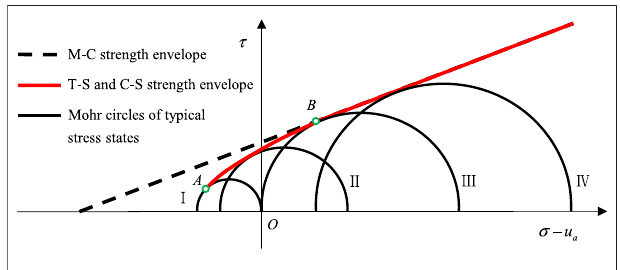
FIGURE 3 | The illustration of typical stress states at soil failure (plane stress